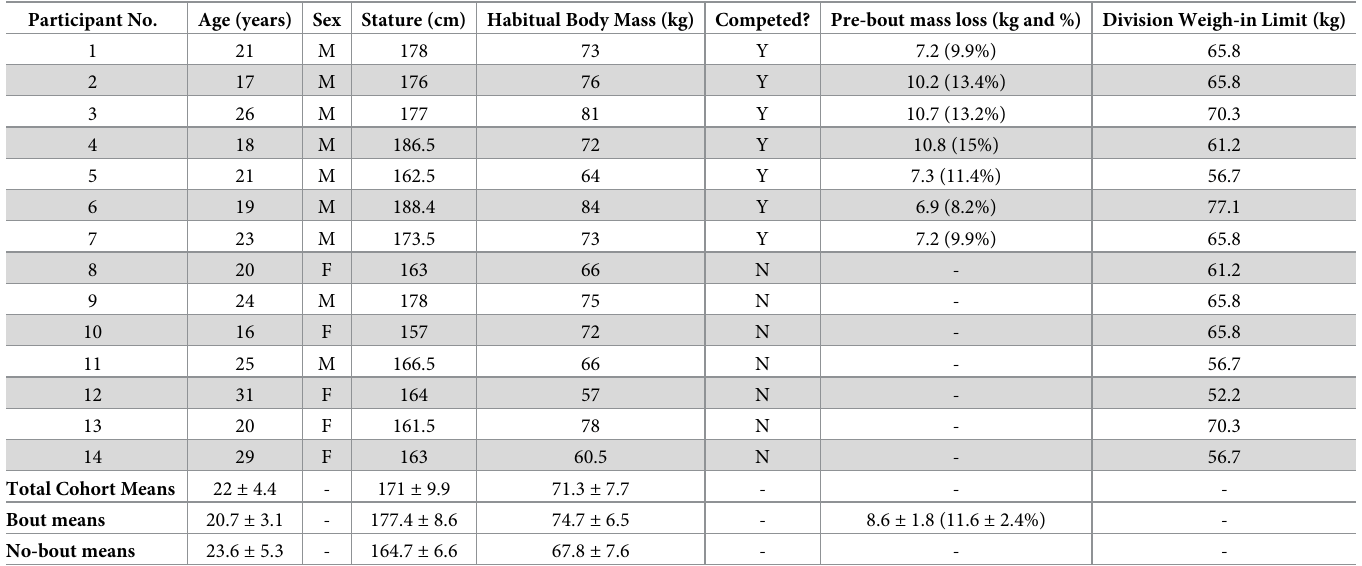
Table 1. Participant descriptive